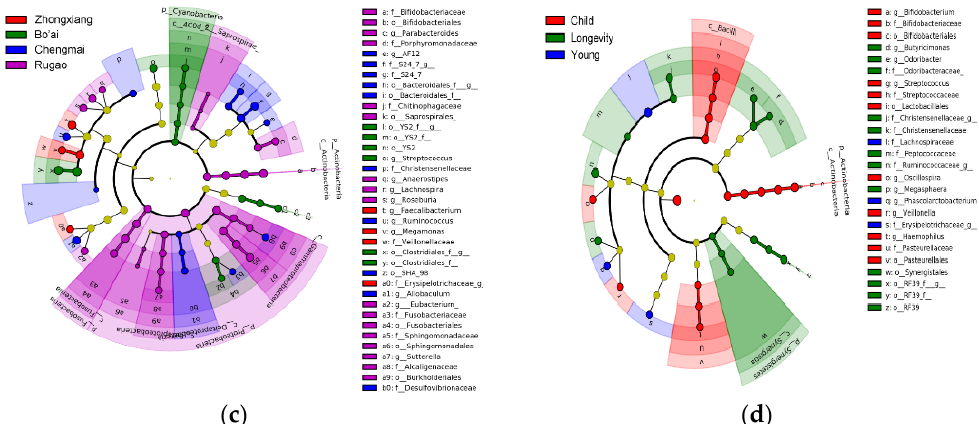
Figure 6. Linear discriminant analysis effect size (LEfSe) analysis of gut microbiota. ( a , b ) show the linear discriminant analysis (LDA) score for discriminated genera in the samples grouped by region and age, respectively, (Wilcoxon rank–sum test, α < 0.05, log LDA > 3). ( c , d ) are the phylogenetic trees depicting bacterial taxonomic hierarchy that is differentially abundant among different groups.